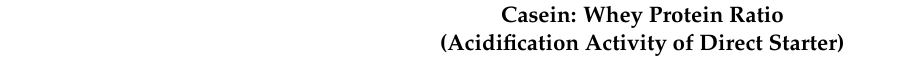
Table 2. Hysteresis area (Pa/s) of stirred gel after 3 d of cold storage ( n = 4). Gels were produced from base milk with casein:whey protein ratio of 4.0:1 or 1.5:1 by inoculation with low- or high-activity starters and fermentation at a fermentation temperature of 37 ◦ C or 42 ◦ C 1 .